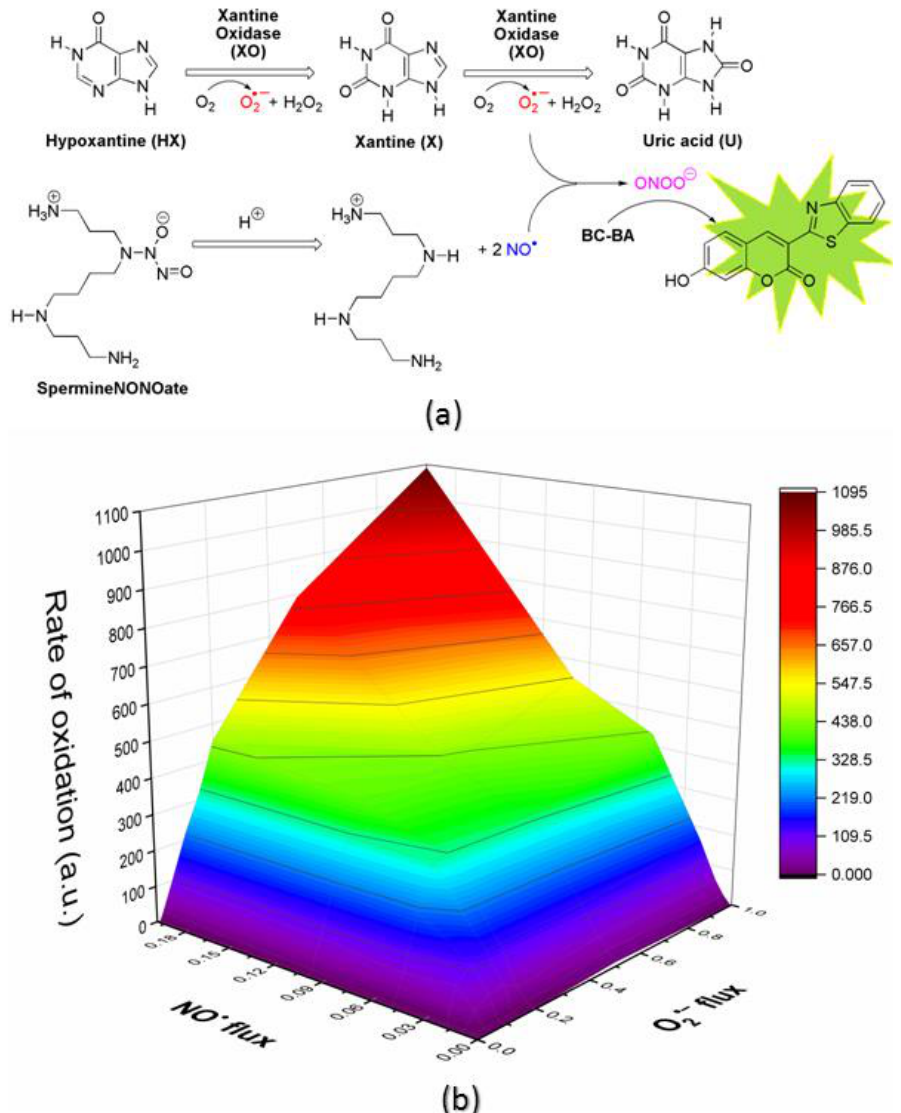
Figure 2. Measurement of peroxynitrite formation in situ by monitoring oxidation of BC-BA